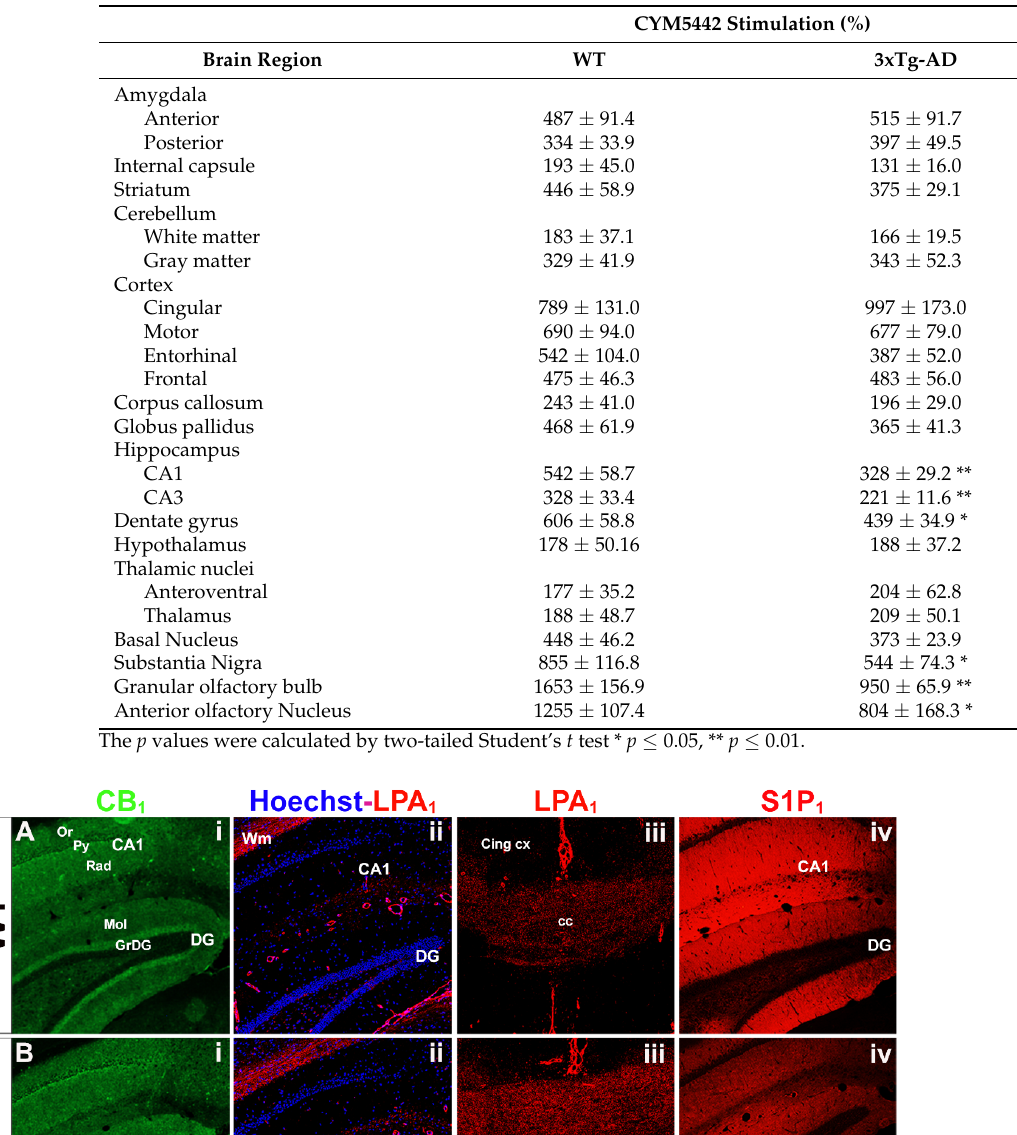
Table 3. [ 35 S]GTP γ S induced by CYM5442 (10 µ M) in different areas of WT and 3xTg-AD mice brain expressed in percentage of stimulation over the basal. n (WT) = 7; n (3xTg-AD) = 7. Data are mean ± SEM values.